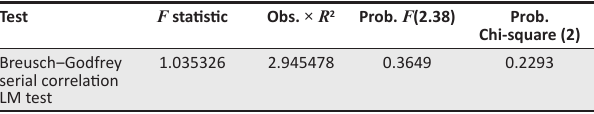
TABLE 6: Serial correlation test for Mangaung.